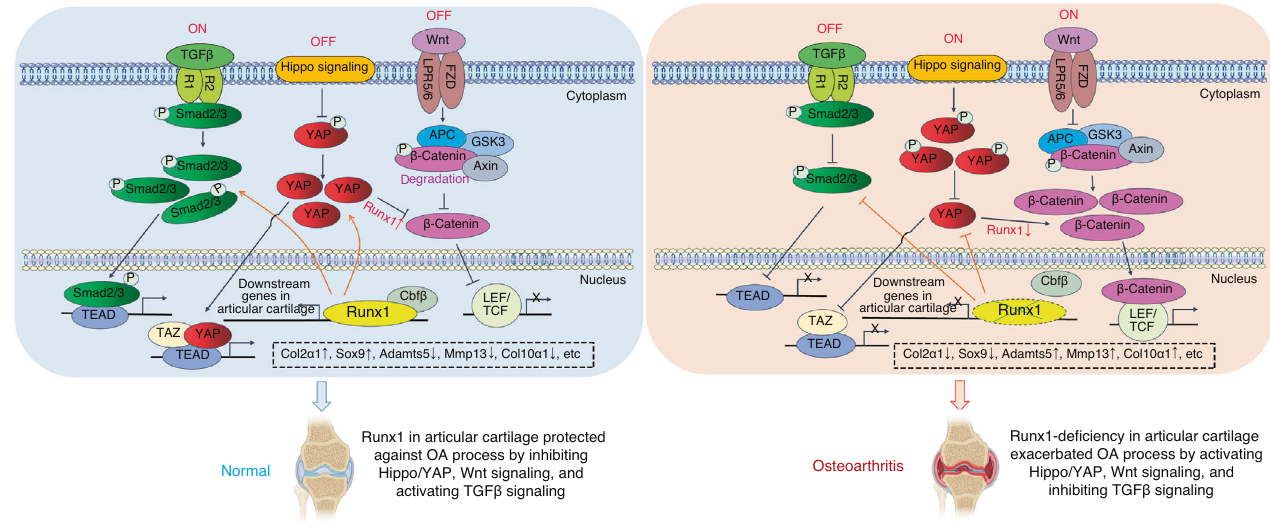
Fig. 7 Working model of the role of Runx1 in articular cartilage formation and OA by orchestrating YAP, TGF β and Wnt signaling they did not fi nd a signi fi cant difference in the 4-month-old Runx1 f/f and Runx1 f/f Col2 α 1-Cre mice. 11 However, their study also found that Col2 α 1 expression and other chondrogenic markers were signi fi - cantly decreased in the 4-month-old Runx1 f/f Col2 α 1-Cre mice, which is also in line with our data from the 4.5-month-old Runx1 f/f Col2 α 1- Cre mice. 11 We speculated that the effect of different mouse sources Bone Research (2022)